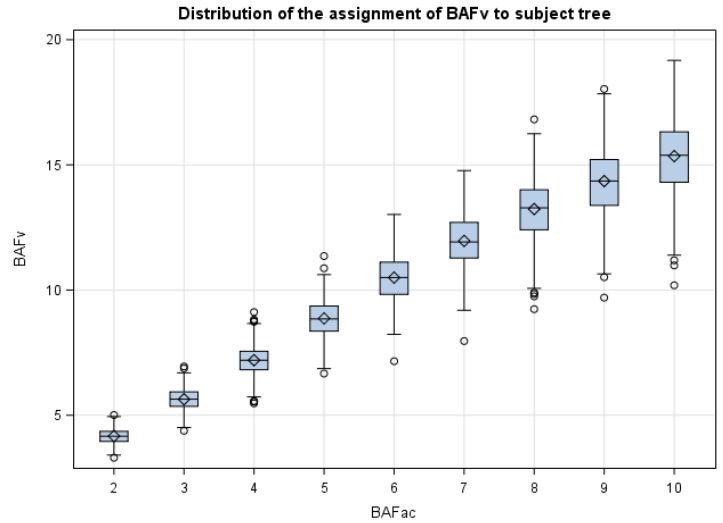
Figure 4. Box plot of the subject tree variable basal area factor ( BAF V ) and the traditional angle count factor ( BAF AC ) for a loblolly pine plantation in Brazil. Each open diamond symbol represents the average value of 500 iterations.